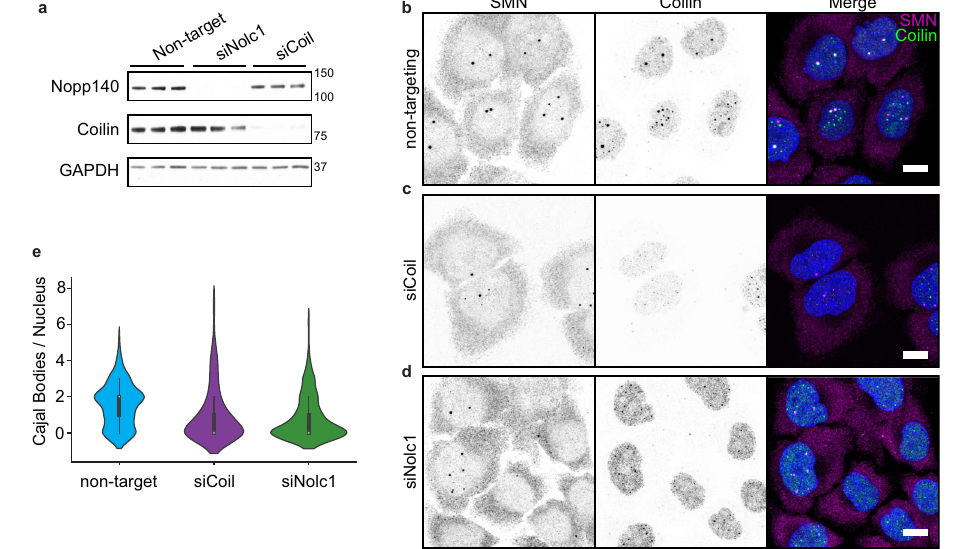
Fig. 2 | Nopp140 is essential for Cajal body assembly. a Western blots of total lysate from three biological replicates of HeLa cells depleted of Nopp140 or coilin using siRNA transfection targeting Nolc1 and coil mRNAs, respectively. Molecular weight markers indicated to the right of the blots. Representative images for cells undergoing transfection with a non-targeting siRNA ( b ), si Coil oligo pool ( c ), or si Nolc1 oligo pool ( d ). Scale bars = 10 µ m. SMN and Coilin signal imaged under